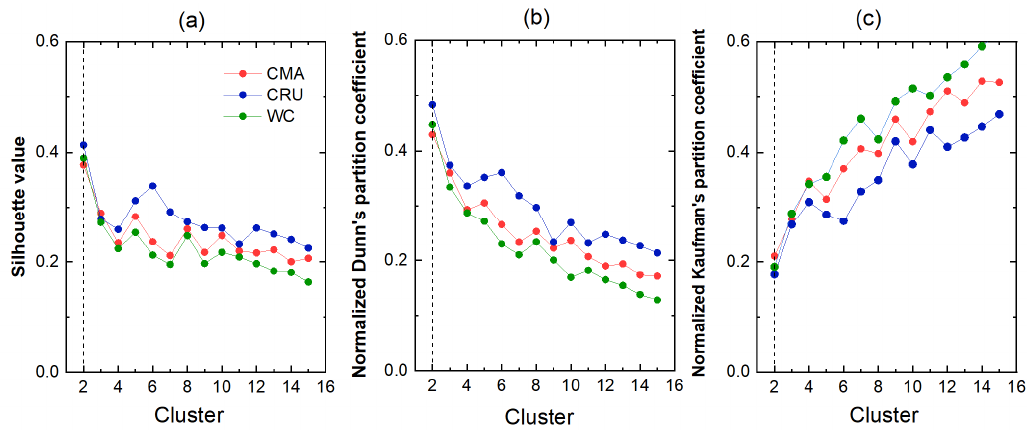
Figure 2. Average silhouette value ( a ) normalized Dunn’s partition coefficient ( b ) and normalized Kaufman’s partition coefficient ( c ) using each meteorological database across the QTP.